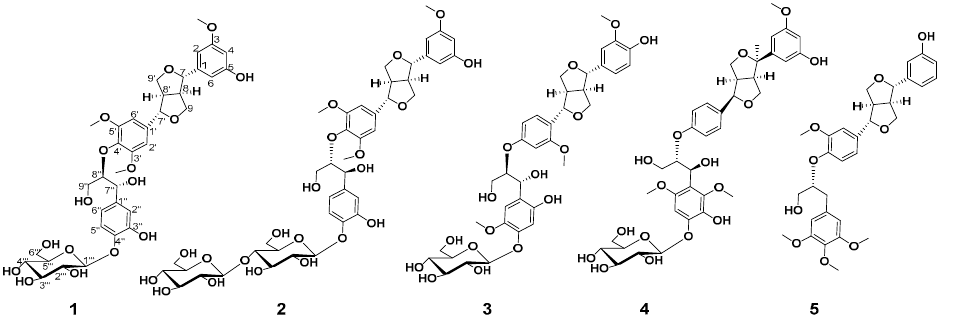
Table 1. 1 H NMR (500 MHz) data of 1 – 5 in DMSO- d